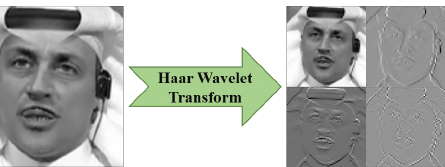
Figure 3. The result of the Haar wavelet transform. The low frequency information map in the upper left corner saves most of the information of the image, and the other three subimages reflect the edge texture information in different